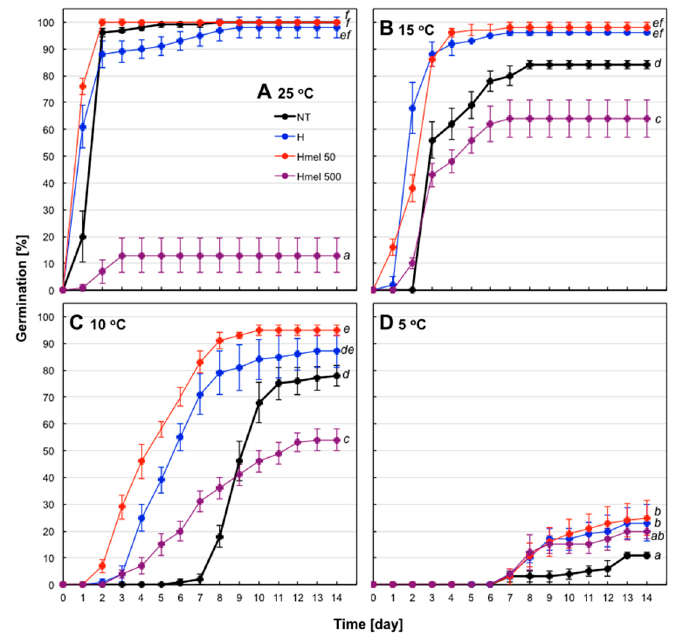
Figure 2. Effect of different maize seed hydropriming treatments on seed germination at optimal, 25 °C ( A ) and chilling: 15 ( B ), 10 ( C ) and 5 °C ( D ) temperatures. The seeds were hydroprimed with water (H—blue line) or with MEL water solution at concentrations 50 μ M (HMel 50—red line) and 500 μ M (HMel 500—purple line). Non-treated seeds (NT—black line) were not primed. Vertical bars represent ±SEM (Samples of 100 seeds; n = 4). GERMINATION 14d—ANOVA results: Seed Variant (NT,H,HMel50,HMel500) F (3;48) = 103.5, p < 0.000001; Temperature (25,15,10,5) F (3;48) = 266.6, p < 0.000001; interaction Seed Variant x Temperature F (9;48) = 24.4, p < 0.000001 .